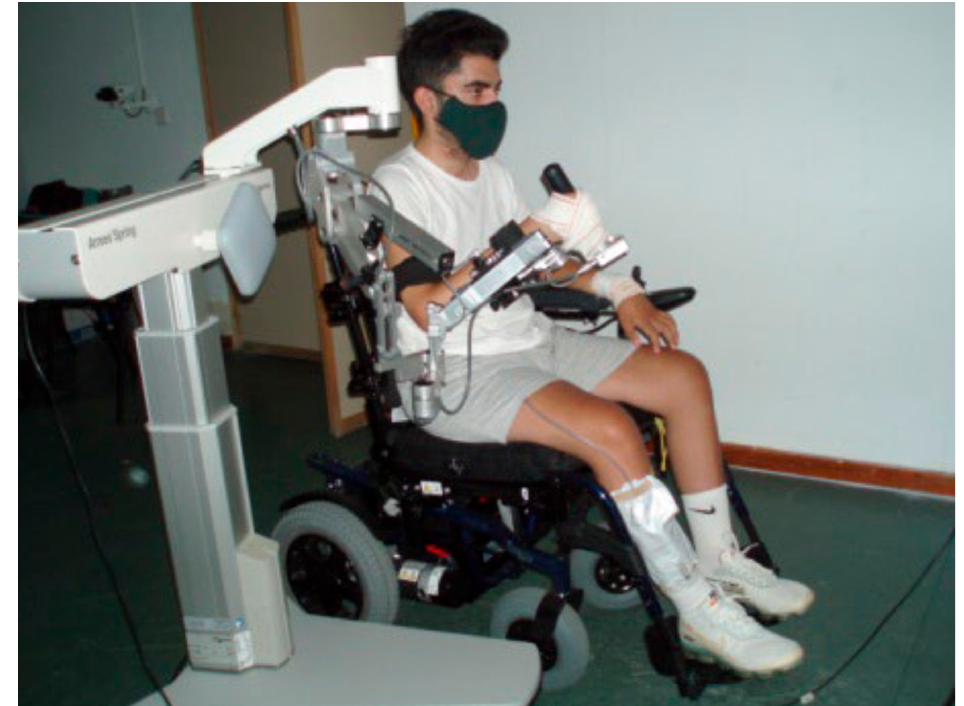
Figure 2. Patient during an experimental session with Armeo ® Spring device.